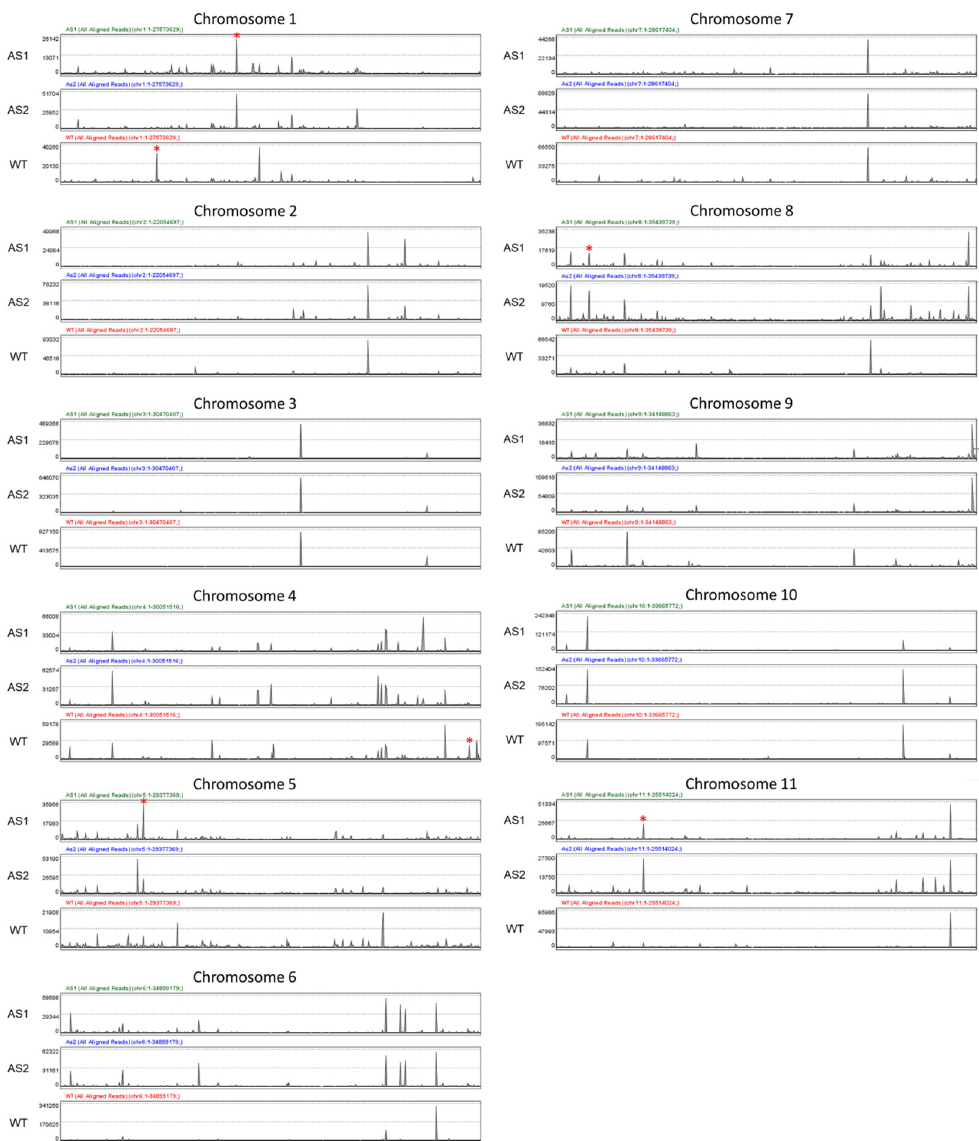
Figure 1. Expression profiles of untransformed wild-type (WT) and two RNAi transgenic banana plants transcriptome RNA-Seq data aligned onto 11 chromosomes of banana by a computationally-optimized Burrows Wheeler transform (called COBWeb) in the Strand NGS software package. The Y -axis indicates the relative expression level as represented by the total number of uniquely mapped sequenced reads (or entities) covered alongside each respective chromosome on an X -axis scale. Genes involved in carbohydrate metabolism are highlighted by the red star. WT, As1 and As2 represent untransformed control, Mh-ACO1, and Mh-ACO2 RNAi transgenic bananas, respectively.